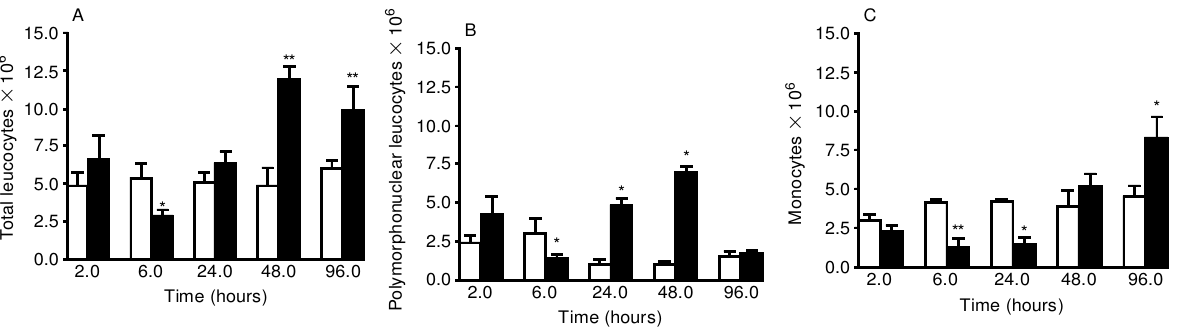
FIG. 1. Time course of cell accumulation in the pleural space following LPS (100 m g / cavity) injection: (A) total leucocytes; (B) polymorphonuclear leucocytes; (C) monocytes. Control, open bars; LPS, ® lled bars. P , 0.05; P , 0.01. Student’s t-test, n = 4 ± 6.